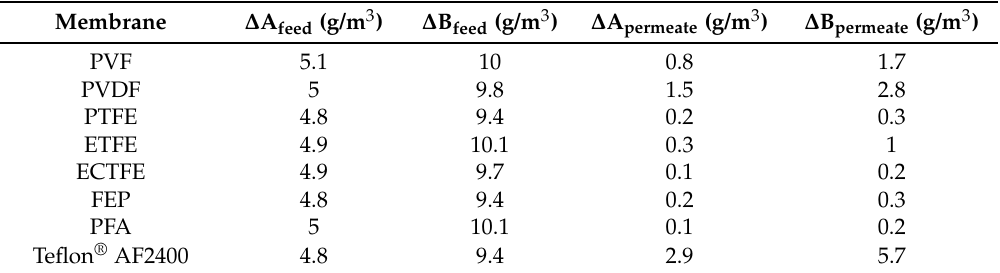
Table 5. Permeability of the PVF, PVDF, PTFE, ETFE, ECTFE, FEP, PFA and Teflon ® AF2400 membranes to water vapor upon variation of the absolute humidity. ∆ A and ∆ B refer to the concentration steps shown in Figure 13. The Permeate and feed concentrations are measured using the T/RH sensor HYT221 from IST AG,